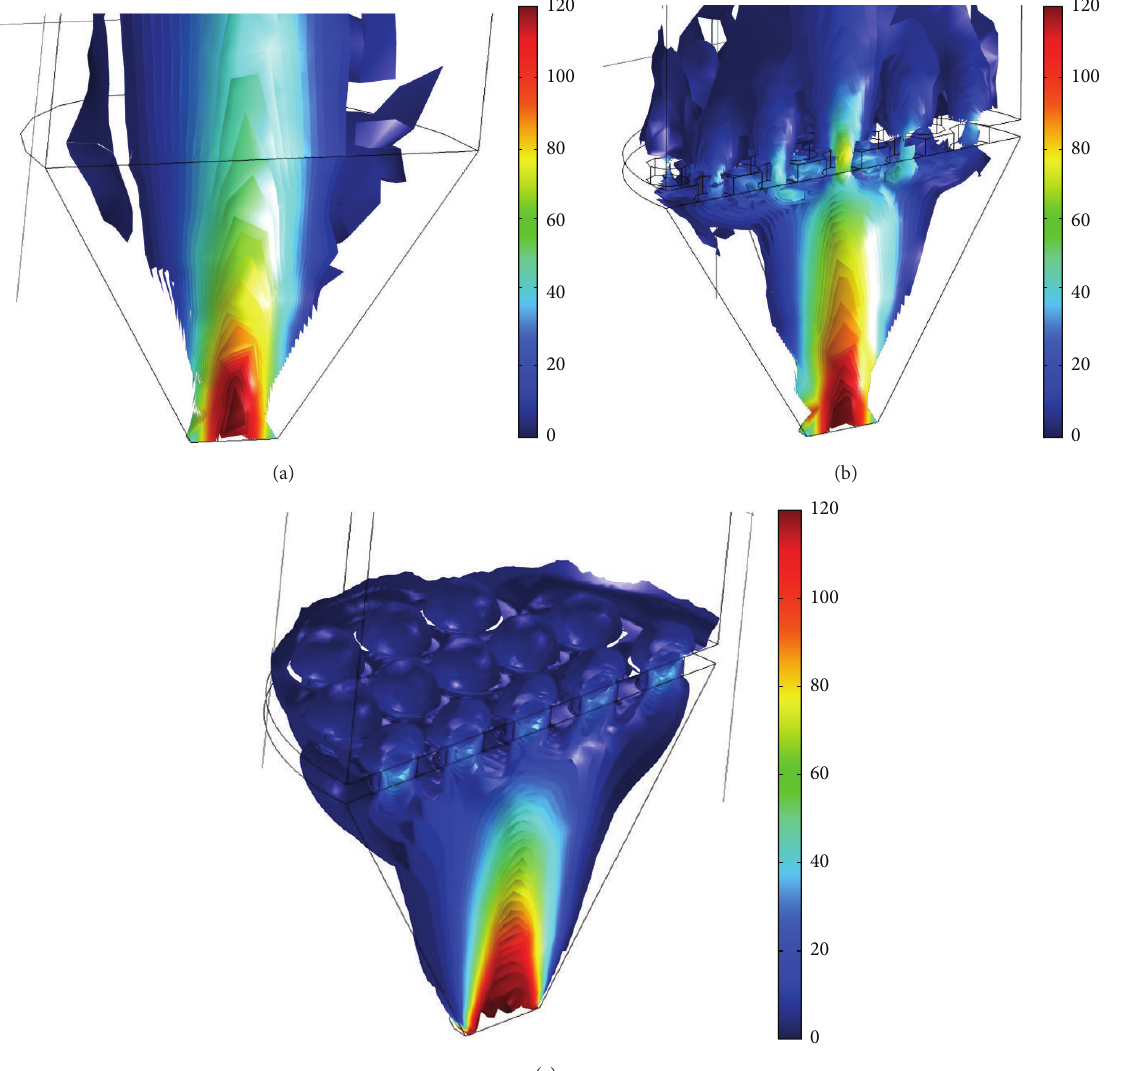
Figure 4: Influent distribution at the bottom of reactors (m/h). (a) No distribution plate and with clean water; (b) with distribution plate and clean water; (c) with distribution plate and sludge